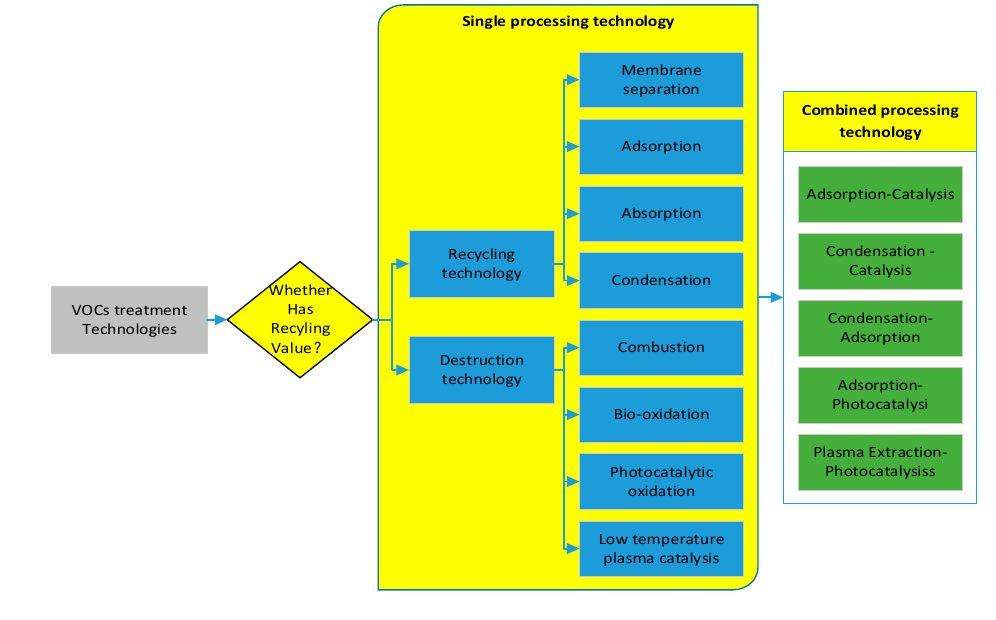
Figure 2. VOCs end processing technology classification architecture diagram.